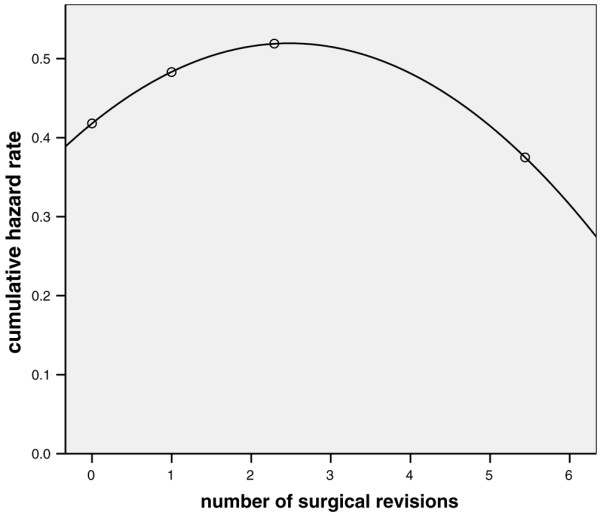
Univariate analysis of surgical efficacy versus cumulative hazard rate: first two years after inclusion. Univariate association between the number of surgical revisions (mean value per quartile) and the corresponding cumulative hazard rate for the first two years after inclusion in patients surviving more than 150 days. P = 0.033 after quadratic transformation of continuous data.